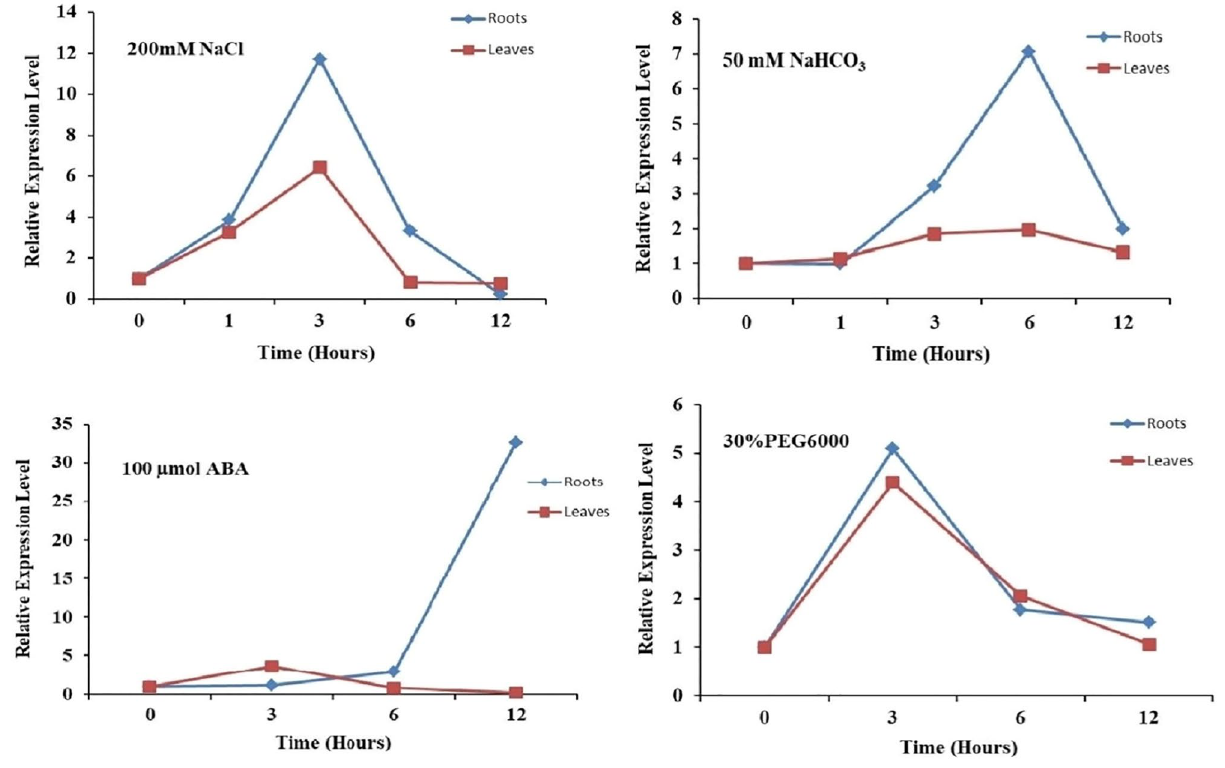
Figure 5. Expression patterns of GsPUB8 in G. soja under the application of salt, alkali, ABA and osmotic stress. GsPUB8 expression was assessed by qRT-PCR via 2 −ΔΔCT method. Here, the error bars signify the ± SE (n = 3).